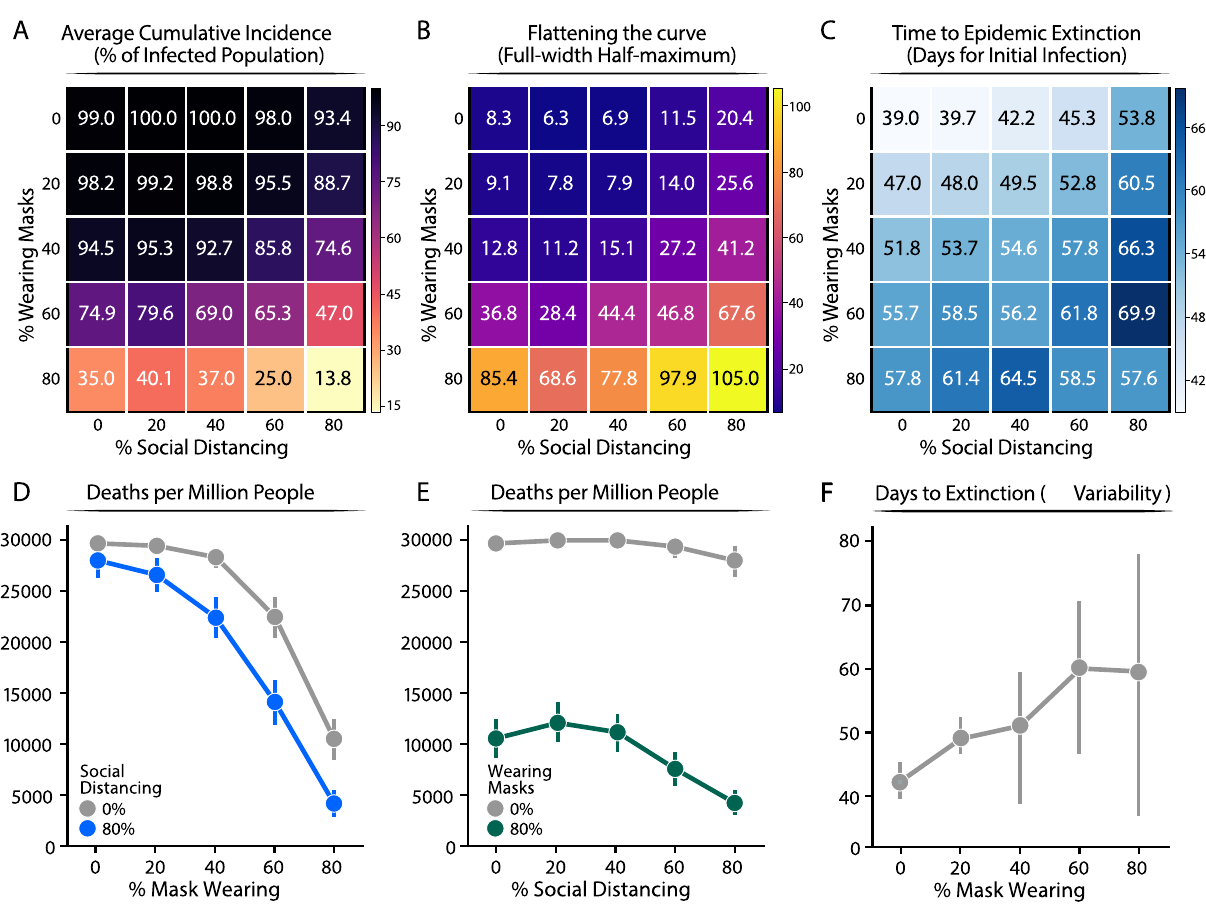
Figure 4. Summary values from 2500 simulations of varying percentages of population wearing masks or social distancing. ( A ) Proportion of infected population. The average cumulative incidence is represented as a function of the population practicing SD or wearing a mask, which are given by the x and y axis, respectively. ( B ) The shape of the daily new infection curve. Full-width half-maximum (FWHM), denoting the number of days between the first day and last day of cases that have half the peak number of infected individuals. ( C ) Extinction rate of the epidemic estimated as the average number of days for which the simulation reports no new infected individuals. In the figure, the numbers represent the mean value calculated over 100 of simulations carried out for each condition. For clarity, we reported the standard deviation of the mean for each value reported in this figure in Fig. SM5. ( D , E ) Number of death people. Extrapolated for one million individuals from the cumulative incidence of infections estimated from our model at a mortality rate of 3%. ( F ) Number of days from the start of infection spread to the last infected agent recovering. Error bars represent 95% confidence intervals calculated for ( D , E , F